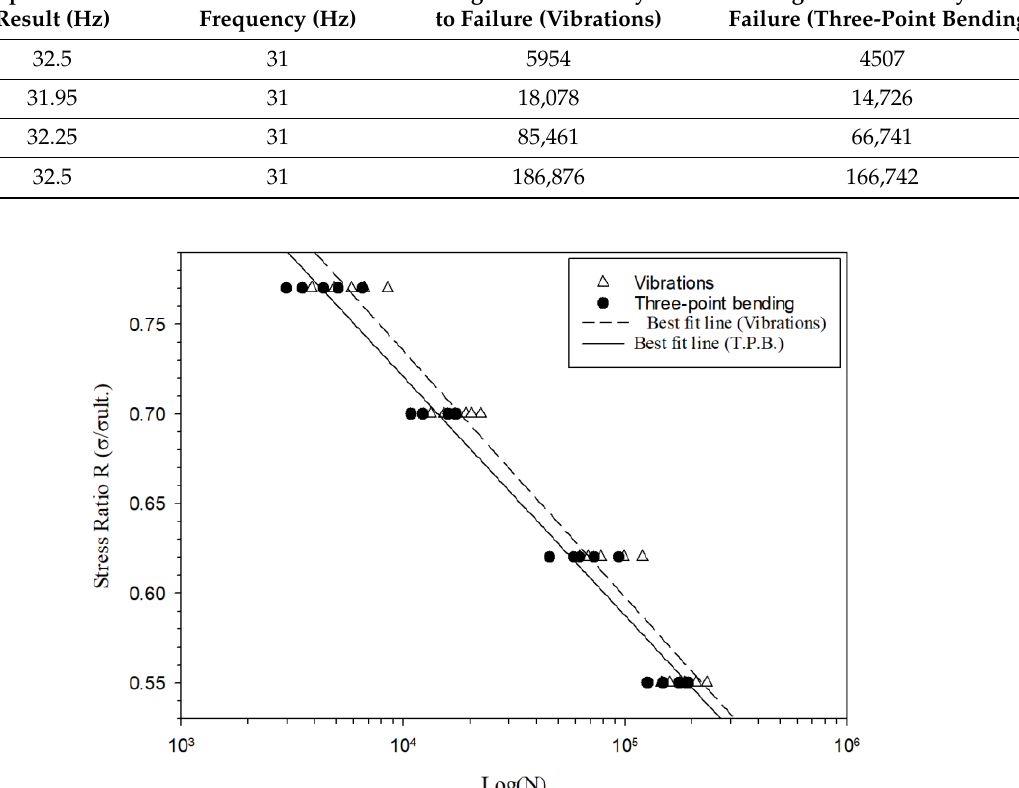
Figure 16. Comparison of sandwich composite fatigue life curves. Failures obtained during three-